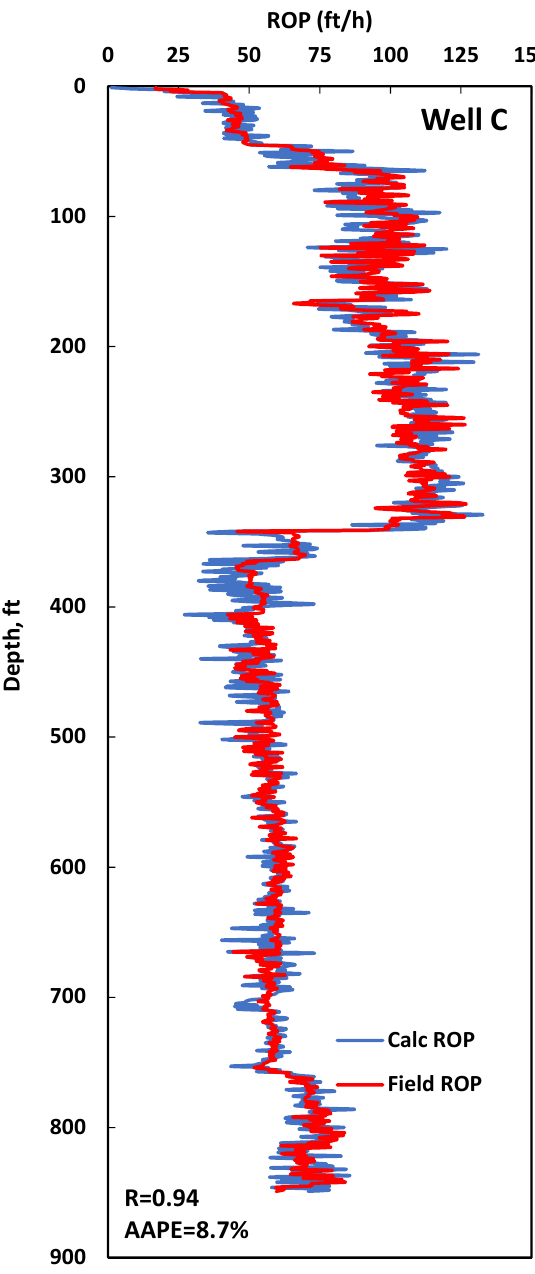
Figure 6. Complete profile of actual ROP vs. predicted ROP from the developed ANN model using data from Wells B and C. Well-B data was used for evaluation the developed ROP model, while Well-C data was used for validating and comparison with other published ROP models.